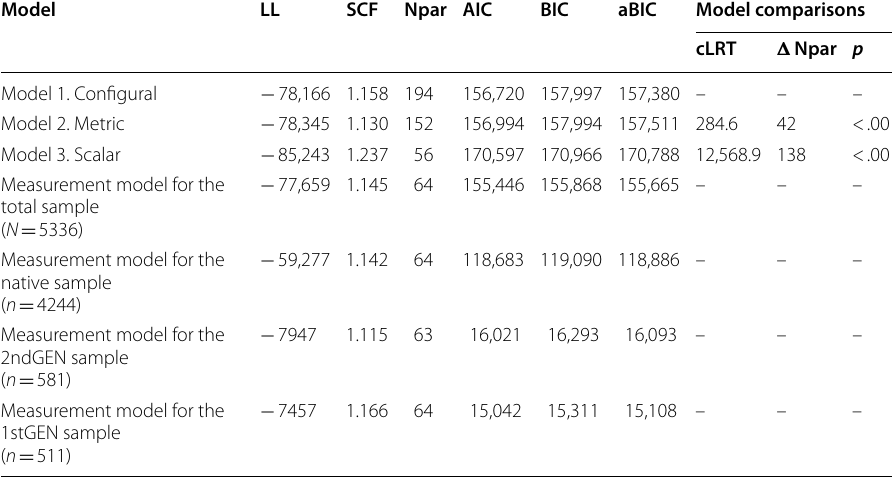
Table 5 Likelihood-ratio tests and information criteria of the multi-group invariance models for Sweden Model